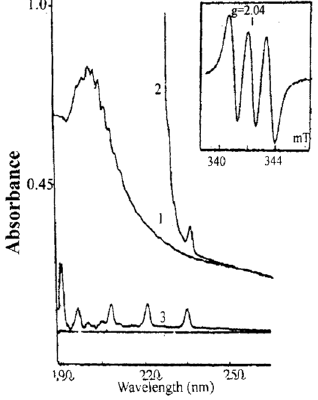
Figure 18. Optical absorption spectra recorded in the gaseous phase in the degassed Thunberg ap- paratus after addition of 700 mM N -methyl-D-glucamine dithiocarbamate (spectrum 1) to B-DNIC-GSH (1.65 mM) and subsequent acidification of B-DNIC-GSH solutions to pH 2.0 (spectrum 2). Spectrum 3—The optical absorption spectrum of gaseous NO recorded at 4 torr pressure corresponding to 24 μ mol of NO (105 mL). The broad band at 204 nm was hypothetically generated by gasiform carbon disulfide released from MGD. All spectra were recorded in a quartz cuvette with an optical path of 40 mm (Figure 13, apparatus A). Inset: The EPR signal of MNIC-MGD recorded after addition of MGD to a B-DNIC solution at ambient temperature [38]. (With permission).